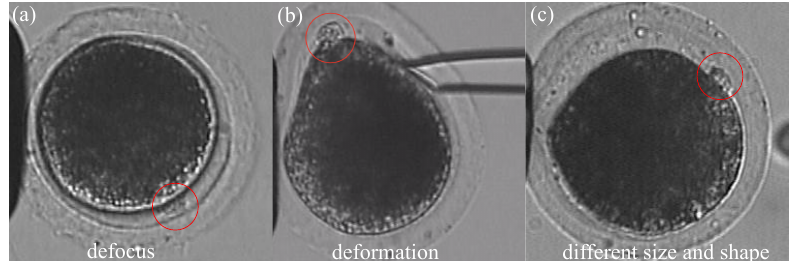
Figure 2. Three typical problems for polar-body detection in oocyte-rotation processes. Polar bodies are indicated by red circles. ( a ) Polar body in defocused situation. ( b ) Polar-body deformation caused by micropipette. ( c ) Polar body in different sizes (height and width of the image are 256 pixels in the whole paper, with 16 pixels representing 10 µ m. Scale bars were added in ( a